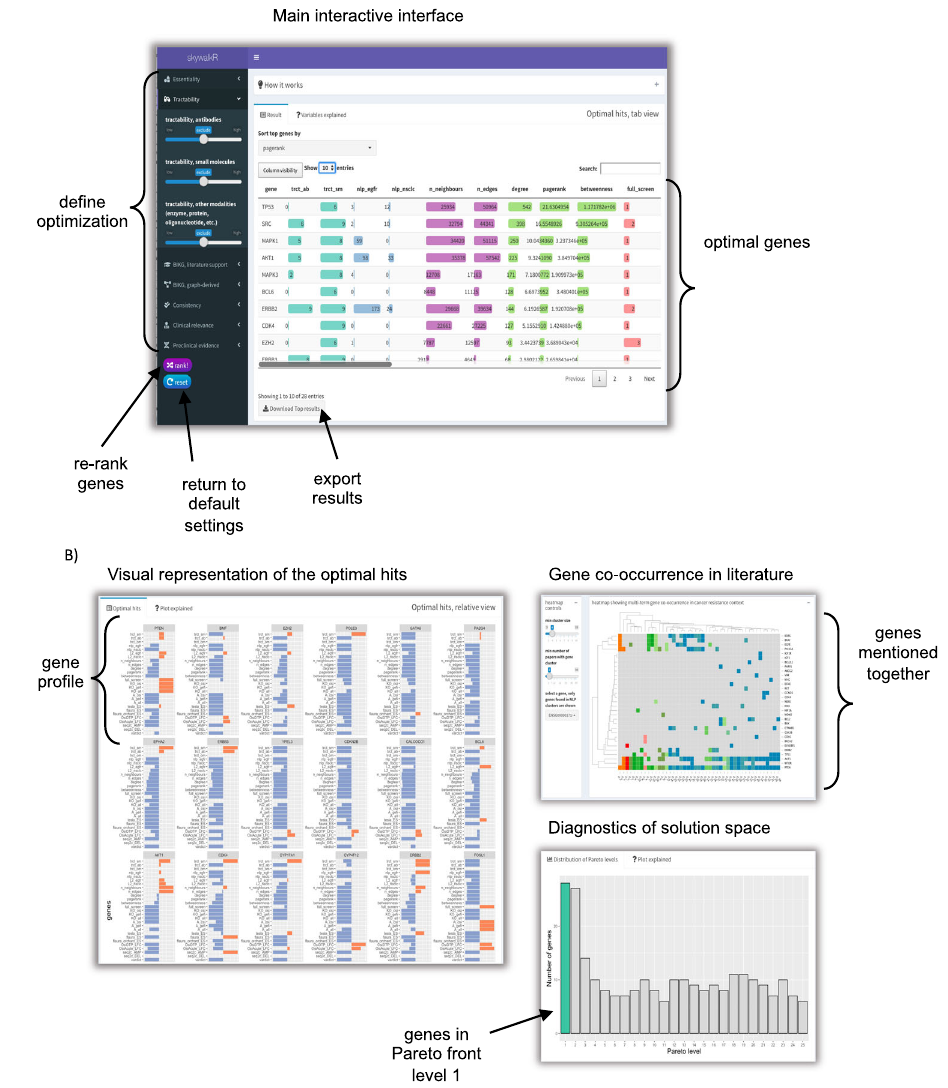
Fig. 2 SkywalkR interactive interface allows users to re-rank CRISPR hits based on various combinations of objectives. A On the side bar panel each objective is represented with a slider. Users can decide which objectives to include in the optimization and can also specify direction of optimization (minimize or maximize). B Additional tools to explore the results. Relative view shows pro fi les of recommended genes. Bar plots demonstrate standardized values across objectives and top recommended genes. Co-occurrence heatmap demonstrates clusters of genes frequently mentioned together in EGFR TKI resistance